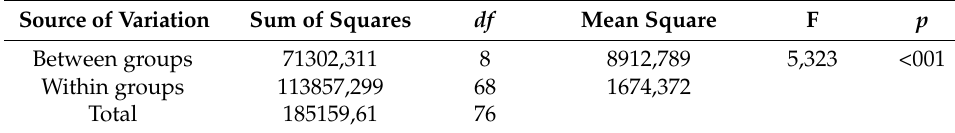
Table 3. One-way ANOVA analysis of failure loads.